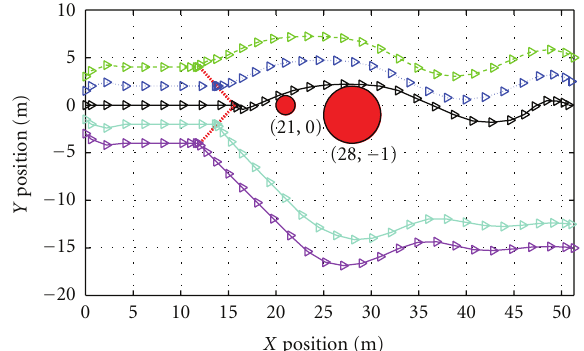
Figure 8: Formation split and obstacle avoidance.